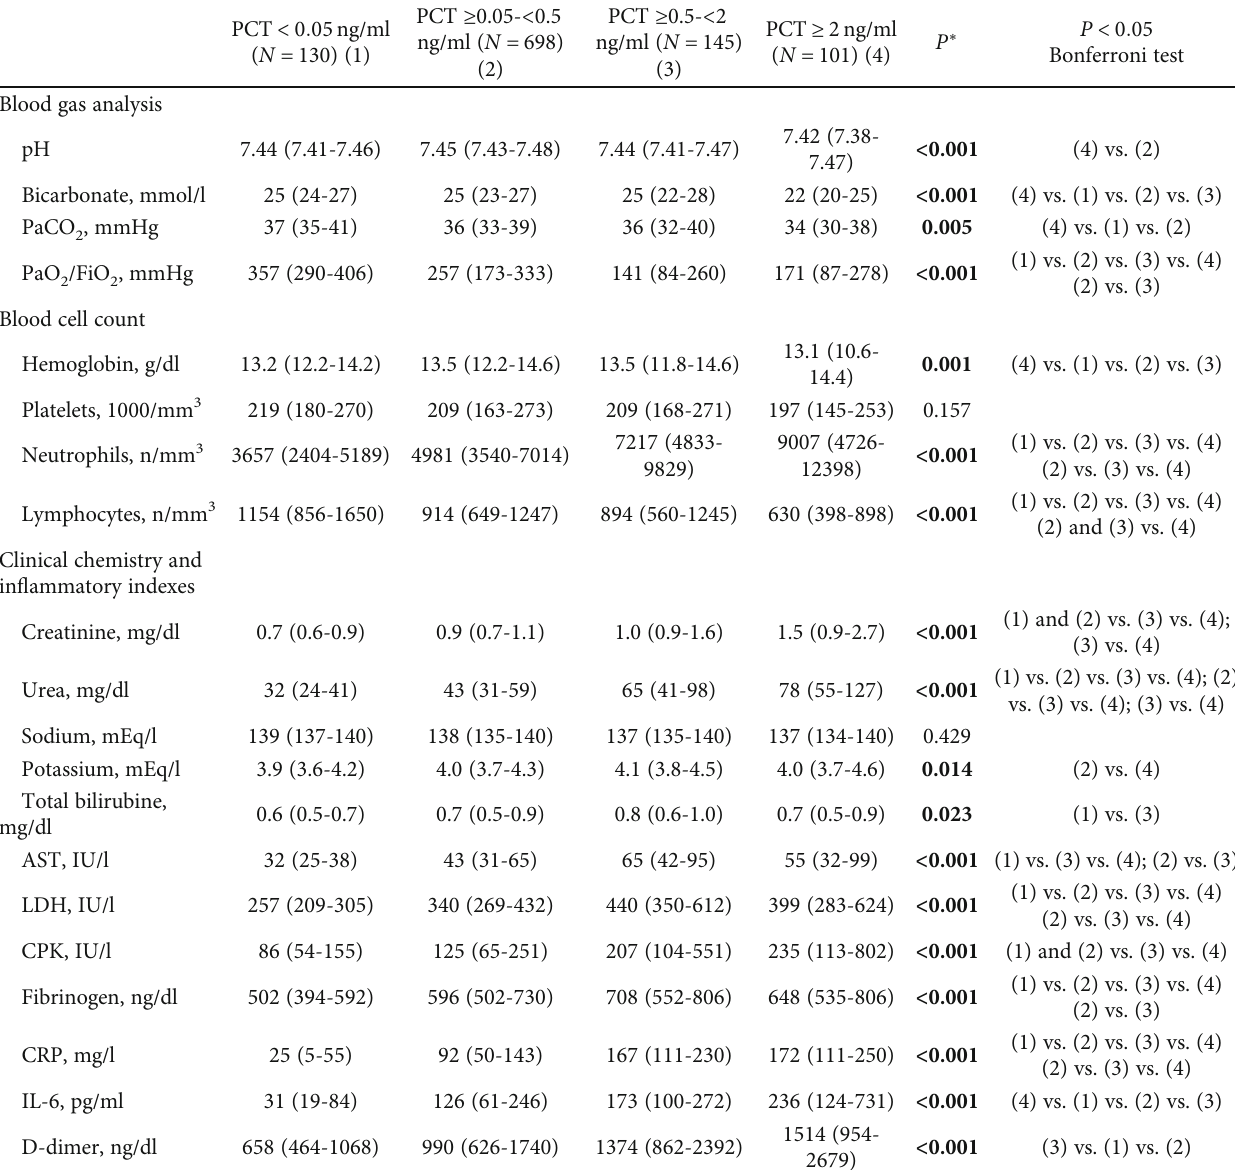
Table 3: Laboratory tests on admission of the 1074 study participants, strati fi ed according to procalcitonin